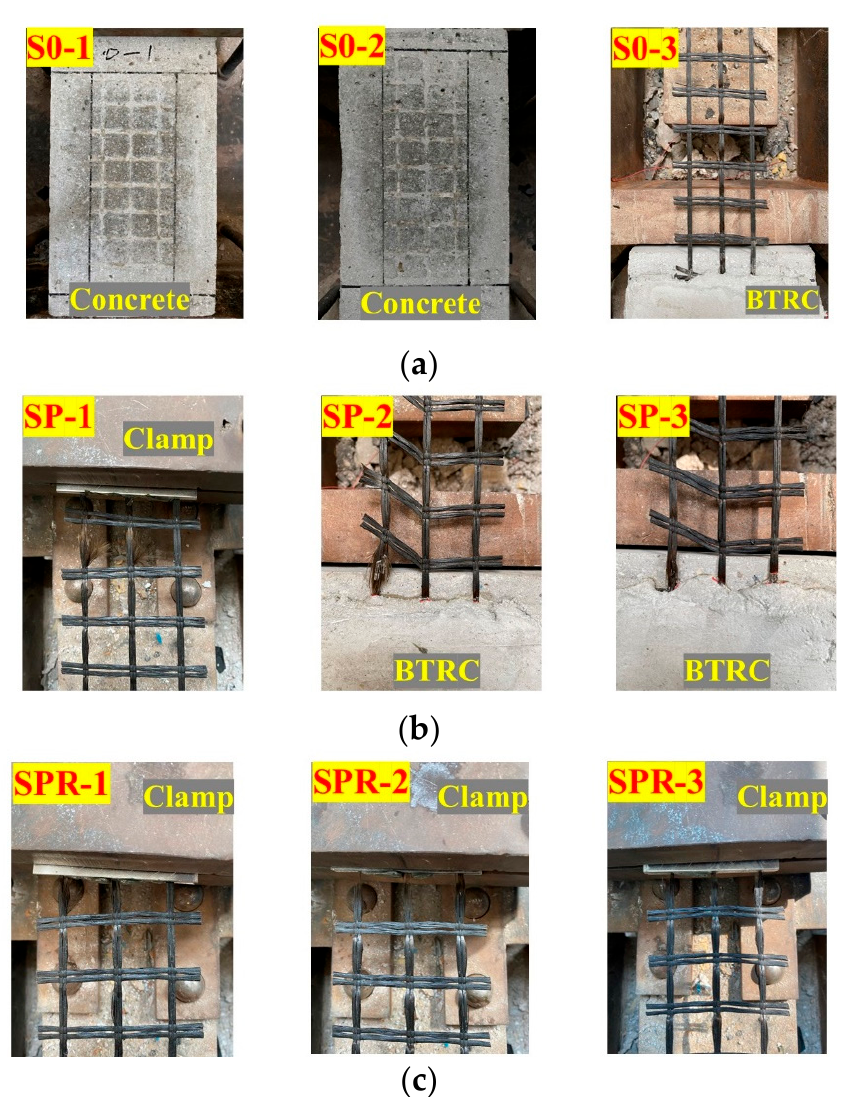
Figure 5. Failure modes observed in single shear tests. ( a ) S0. ( b ) SP. ( c ) SPR.